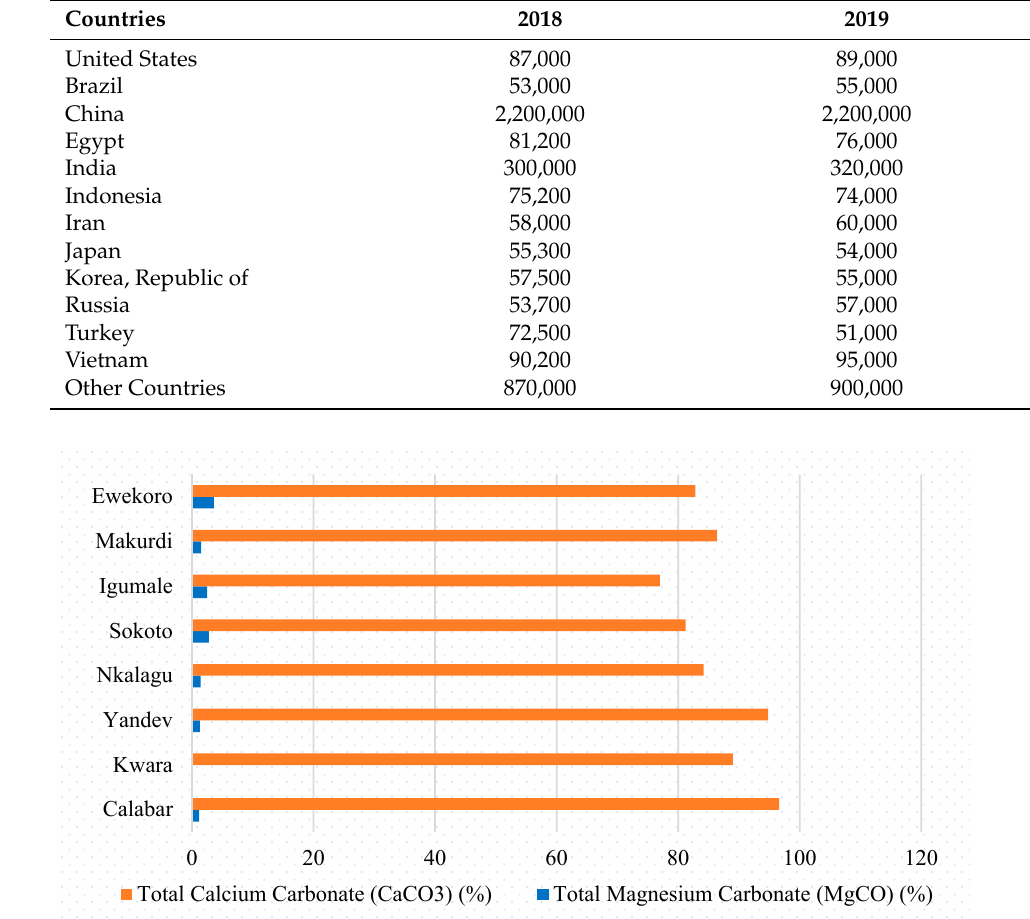
Table 2. Global cement production in selected countries (in metric tonnes) [6].